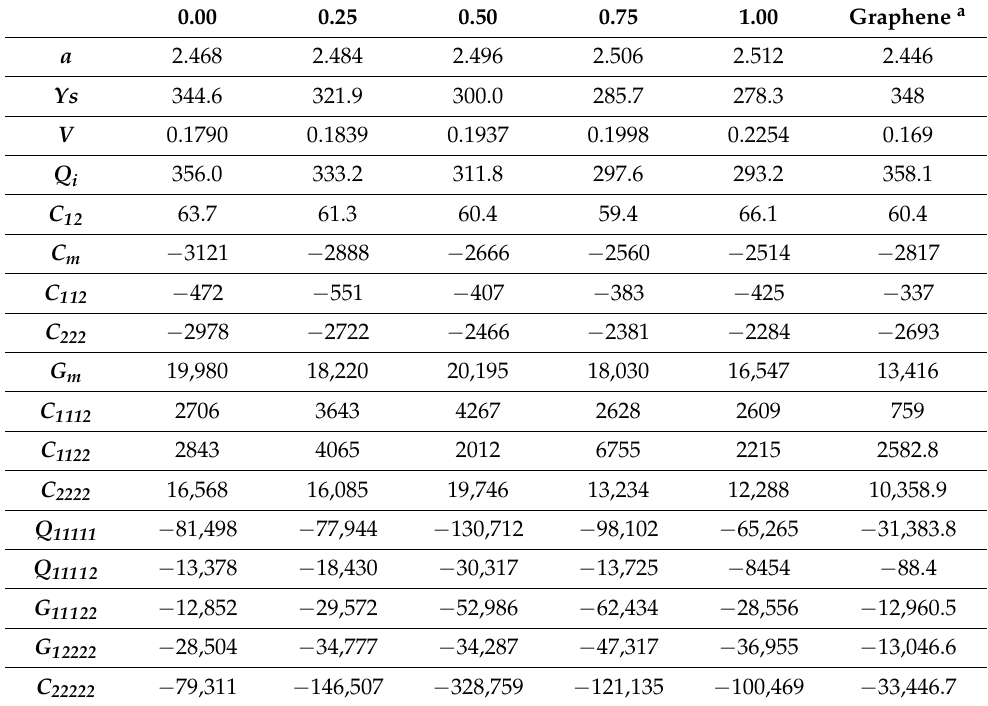
Table 1. Lattice constants a , in-plane stiffness Y s , Poisson’s ratio ν , and high-order elastic constants of g -BNC from DFT calculations, compared to previous calculations of